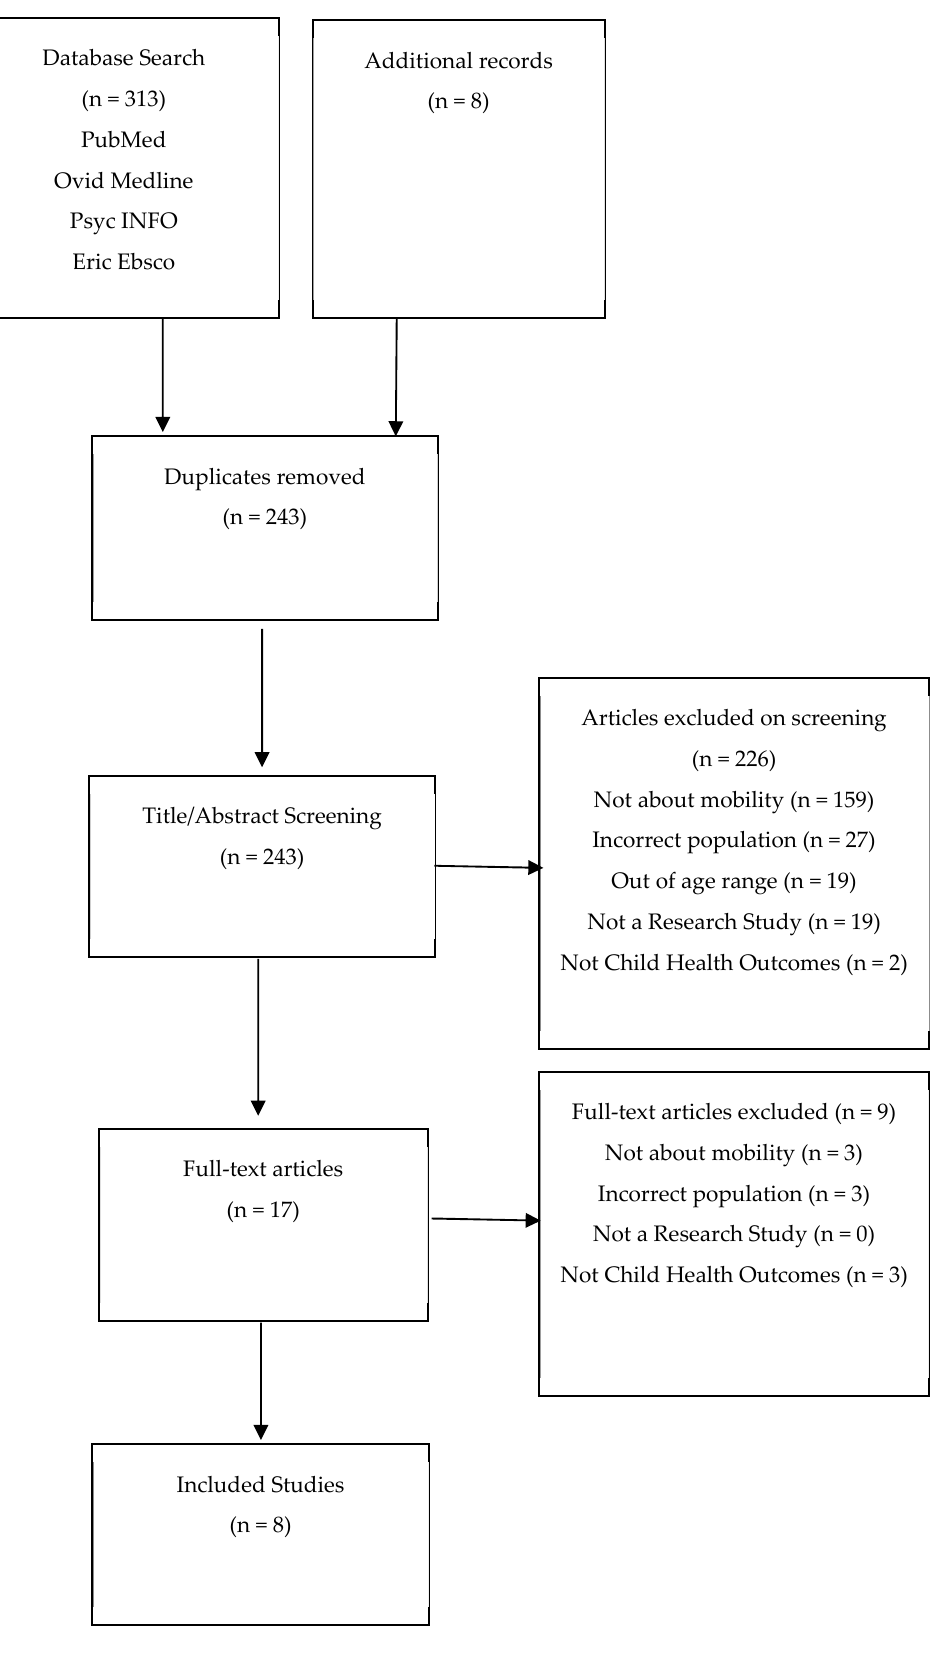
Figure 1. PRISMA Flow Diagram of study selection.